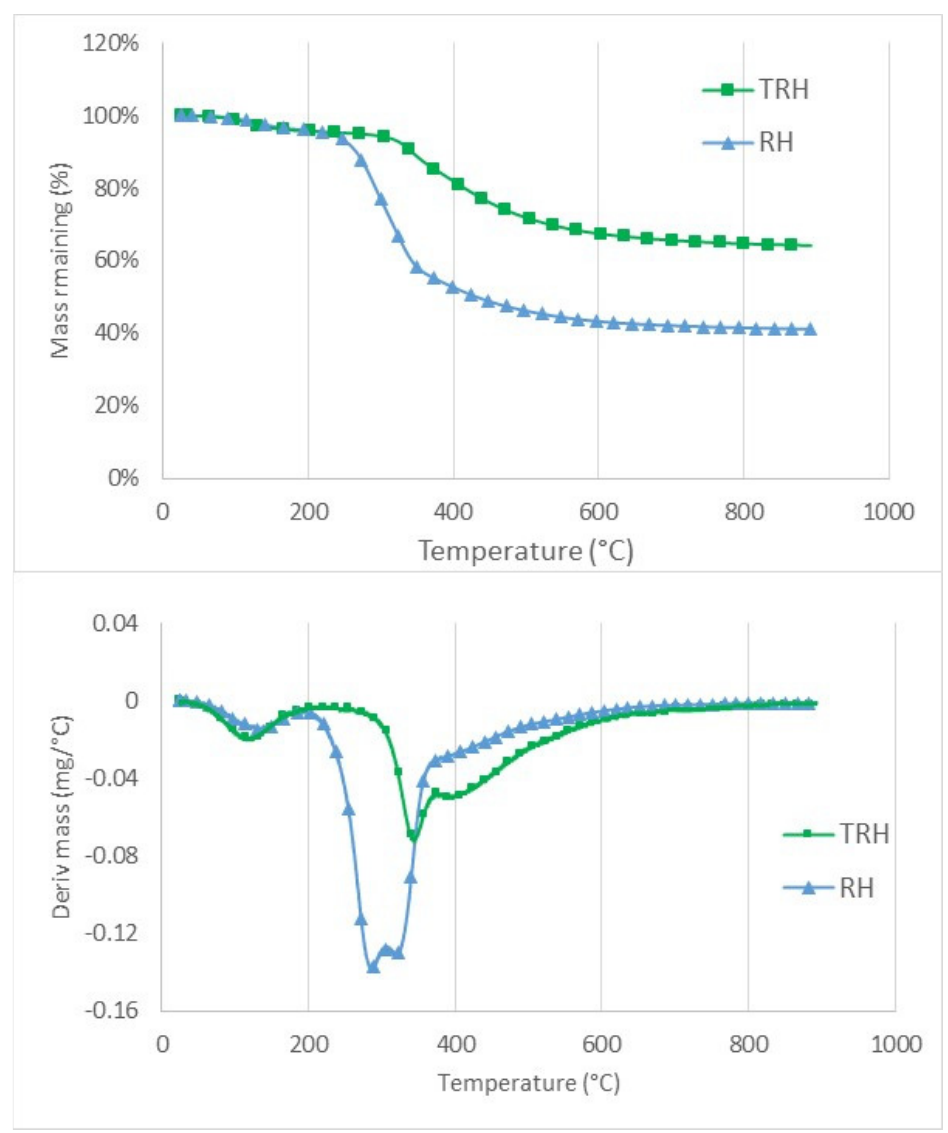
Figure 2. TG ( top ) and DTG ( bottom ) curves for raw rice hulls (RRH) and torrefied rice hulls (TRH).